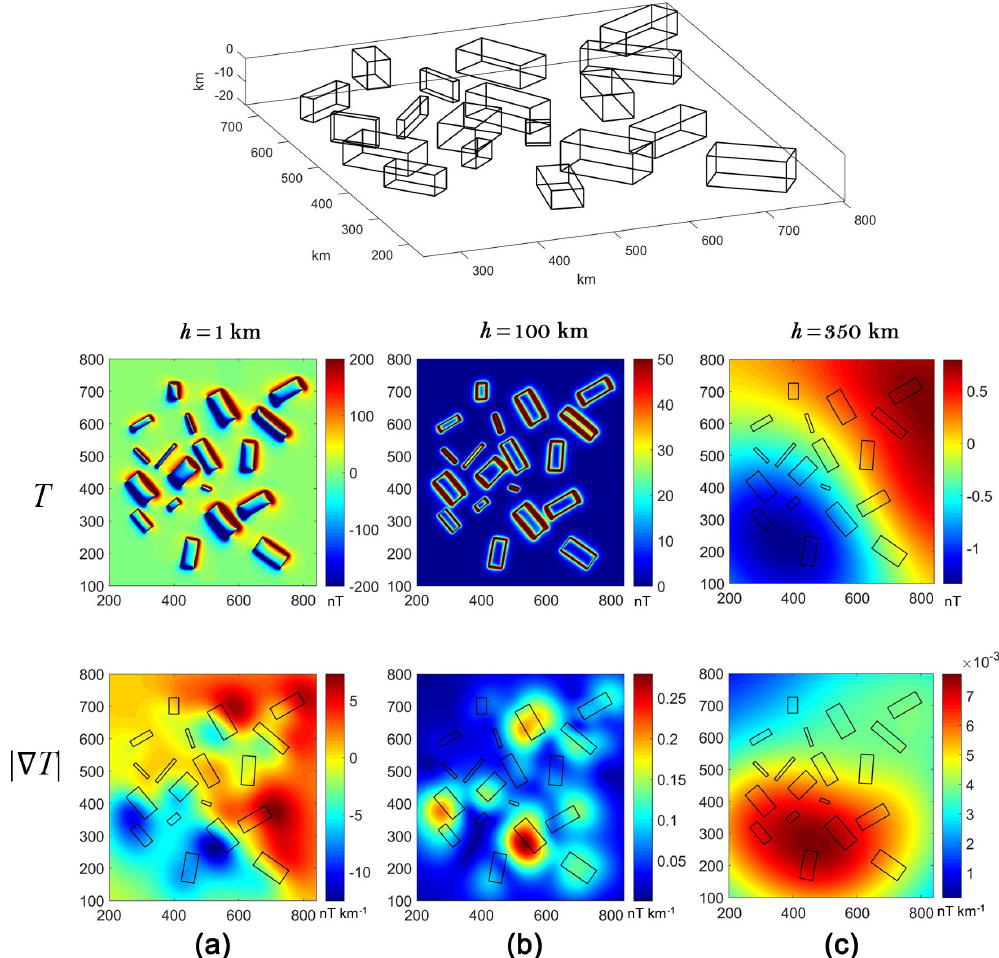
Figure 6. Synthetic model of the multiple shallow sources reversely magnetized. The magnetic field ( T ) and total gradient |∇ T | maps are shown at 1km (a) , 100km (b) and 350km (c)